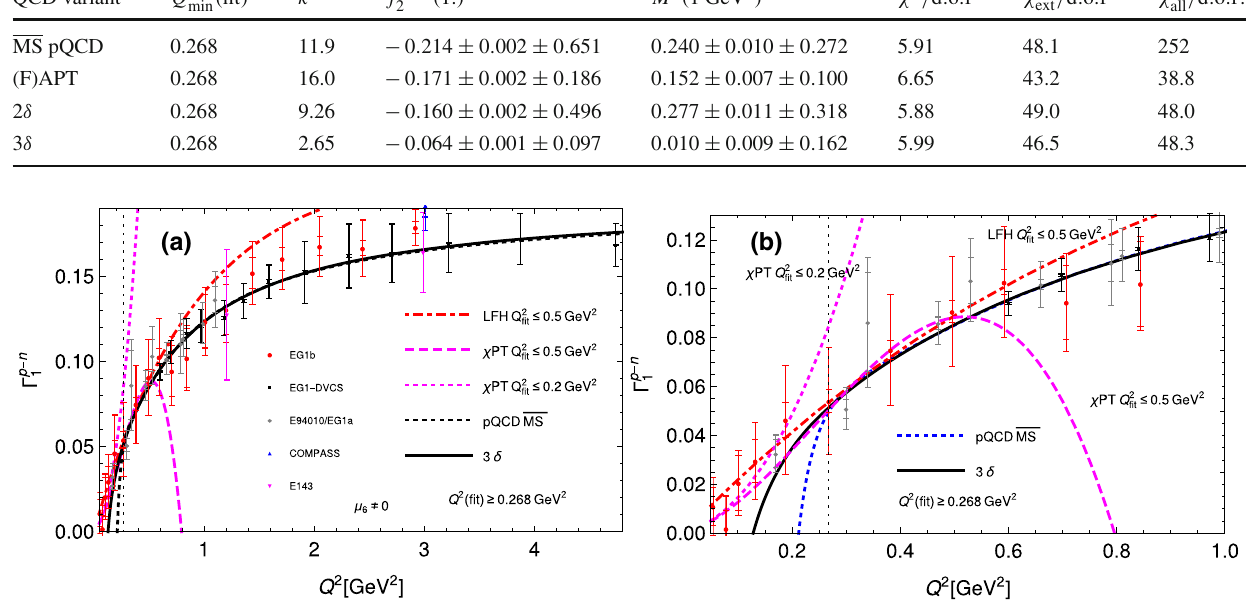
Fig. 6 As Fig. 3, but now with the low- Q 2 expressions (18) and (19) included. b is a zoomed-in version of a , for Q 2 < 1 GeV 2 . The lower bound = 0 . 268 GeV 2 , is included as the thin dotted vertical of the fitting interval, Q 2 min